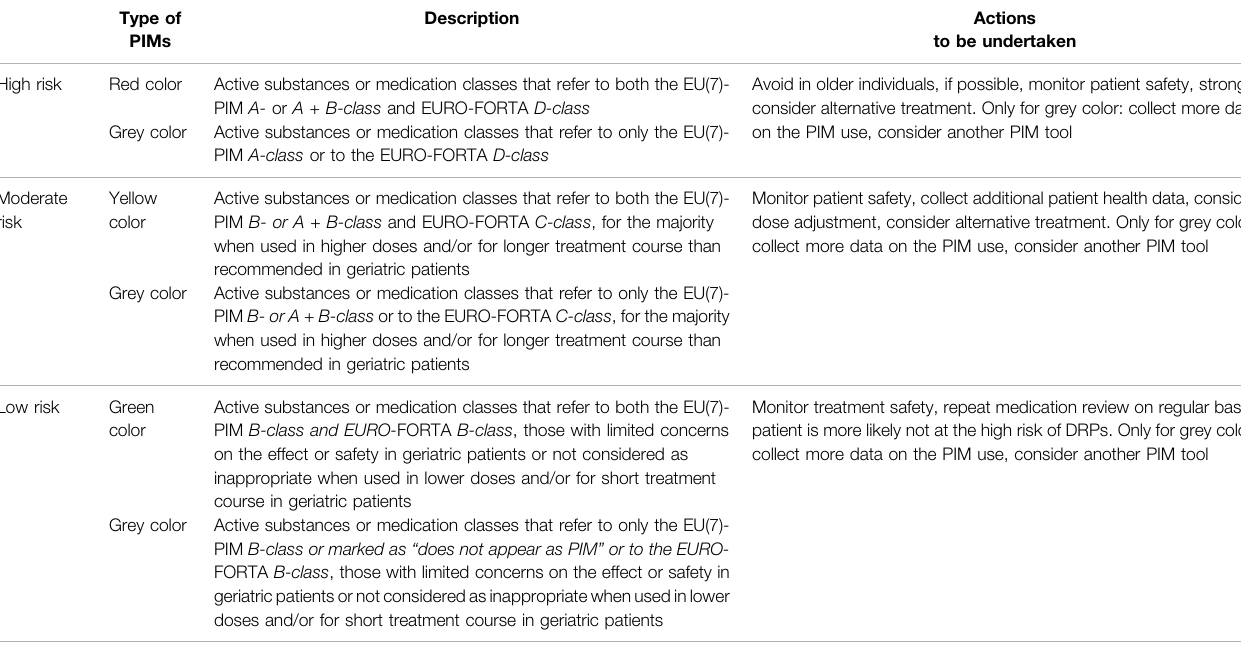
TABLE 2 | Detailed description of the integrated screening tool based on the EU(7)-PIM 1 and EURO-FORTA 2